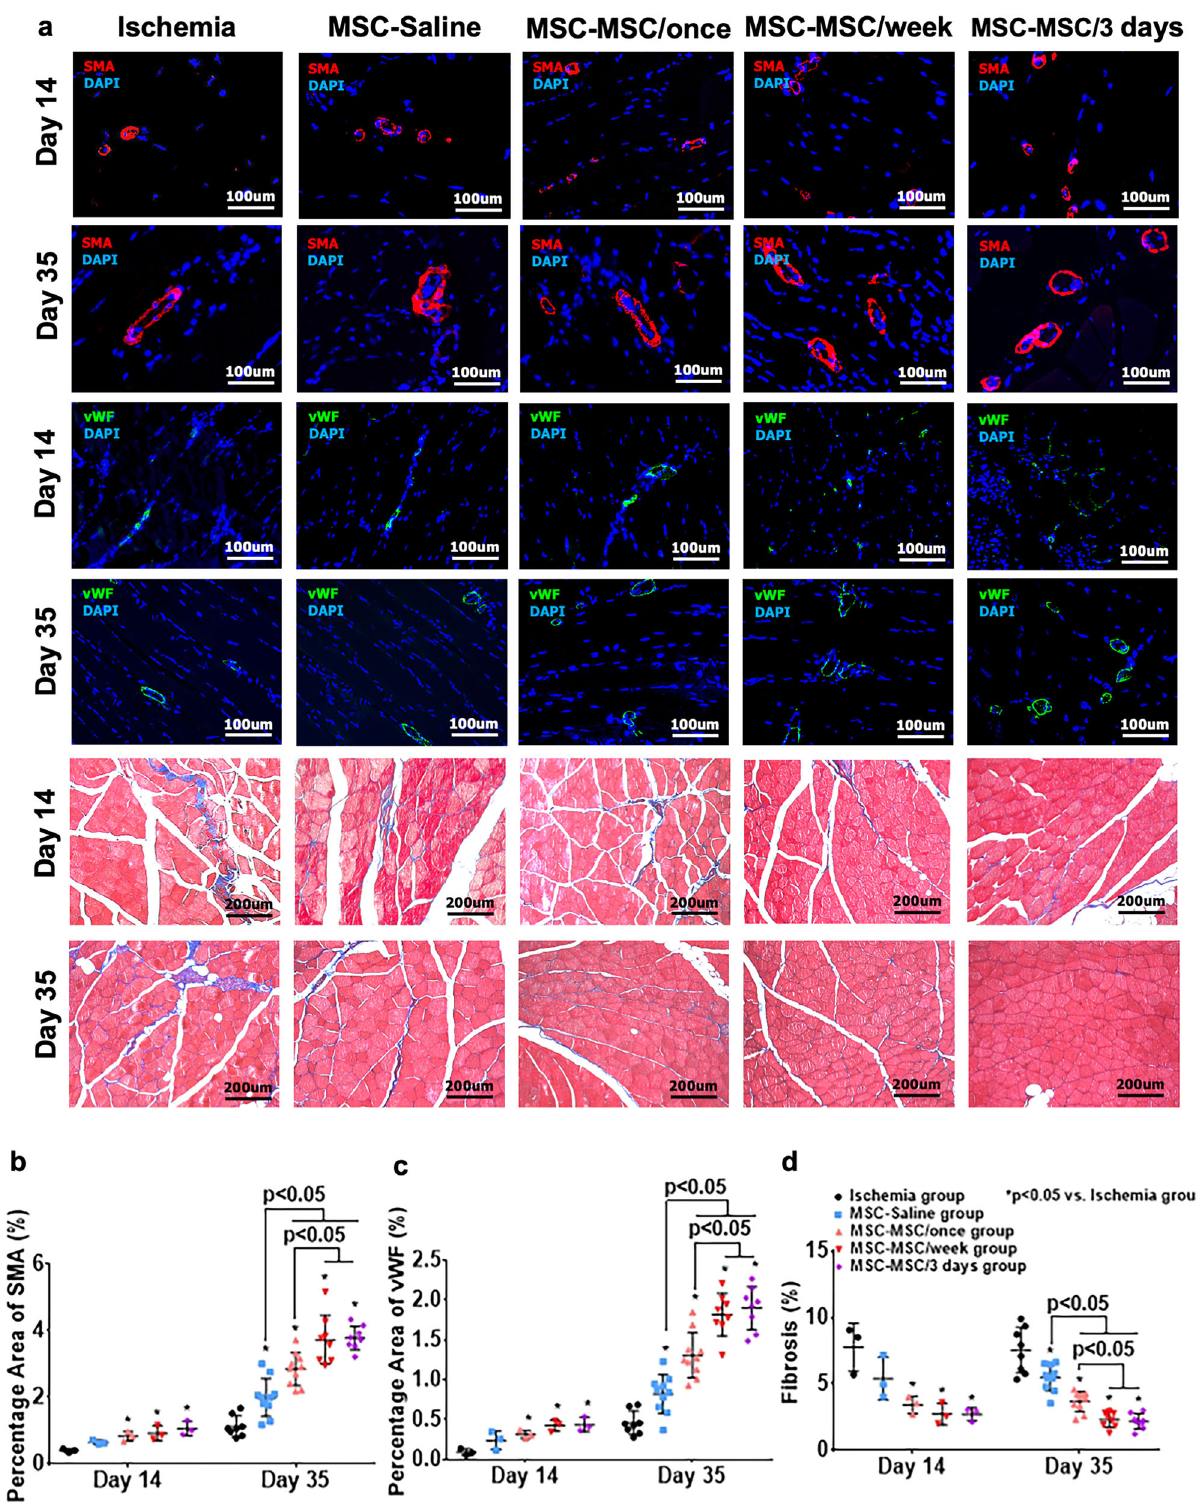
signi fi cantly reduced fi brosis compared with the ischemia group (Fig. 4d, all p < 0.05). Compared with the ischemia group, intramuscular transplantation of hiPSC-MSCs in the MSC-Saline, MSC-MSC/once, MSC-MSC/week and MSC-MSC/3 days groups signi fi cantly ameliorated fi brosis on day 35 (Fig. 4d, all p < 0.05). Moreover, systemic intravenous administration of hiPSC-MSCs in the MSC-MSC/once, MSC-MSC/week and MSC-MSC/3 days